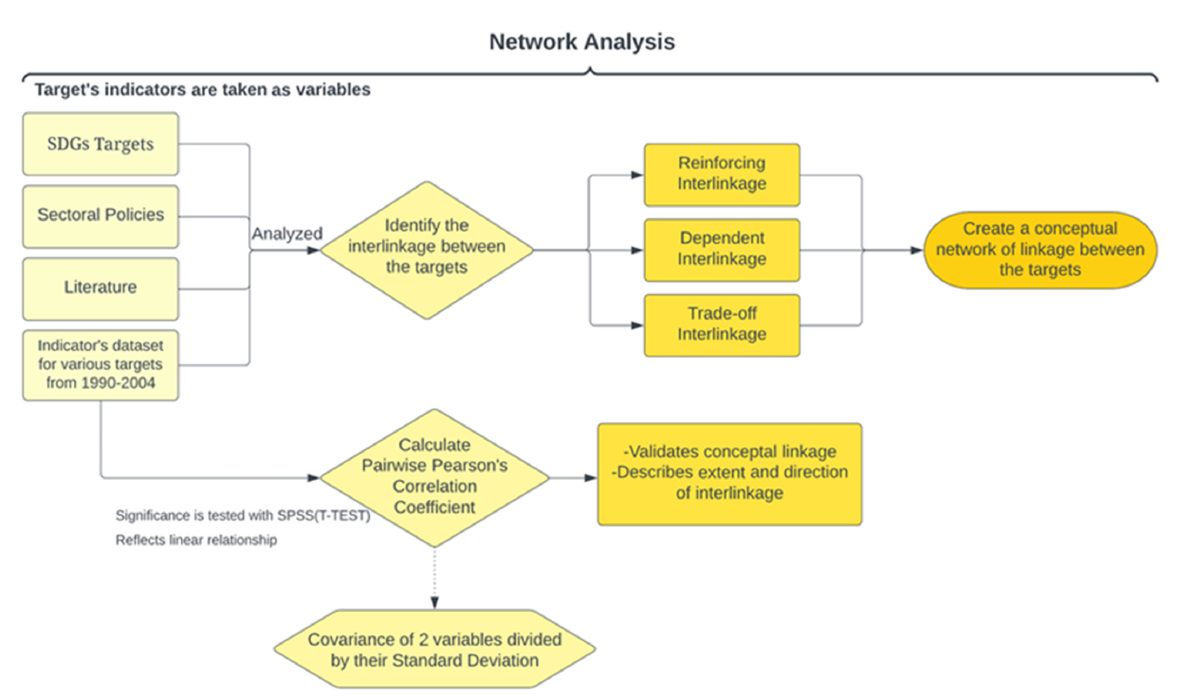
Figure 3. Description to analyze the extent and direction of interlinkages between the SDGs. 2.3. Advance Sustainability Analysis: Evaluation of Synergy and Trade-Offs between SDGs This study analyzes the synergy and trade-offs between the SDGs and their associ- ated targets with the application of advance sustainability analysis (ASA) approach. The ASA approach was developed under the European framework programmes (FP6 and FP&) [6] and has been used in various studies for the quantification of synergy and trade- offs [6,37–39]. ASA emphasizes the application of an explorative approach that explains the presence of synergy (positive or negative) between two variables. The description of evaluating the synergy and trade-off between SDGs applying ASA is presented in Figure 4. The estimate here is obtained by calculating the ratio between the changes in these trends. This method estimates the possible synergy among the accomplished trends that depicts patterns of development which are in different dimensions of sustainable devel- opment [6,38,40]. Here, targets under observation are analyzed to evaluate synergy/trade- off between the two variables representing statistical interaction and is measured by the ratio of relative changes between the two variables in each specific time-period. The vari- ables are normalized in the calculation and the synergy is expressed as an index range from +1 to − 1. Minus ( − ) sign represents a trade-off situation. Synergies have been evalu- ated for each five-year time span (1990–1994, 1995–1999, 2000–2004, 2005–2009, and 2010– 2014). The historical datasets for the indicator of the targets between 1990 to 2014 are listed in Appendix A.